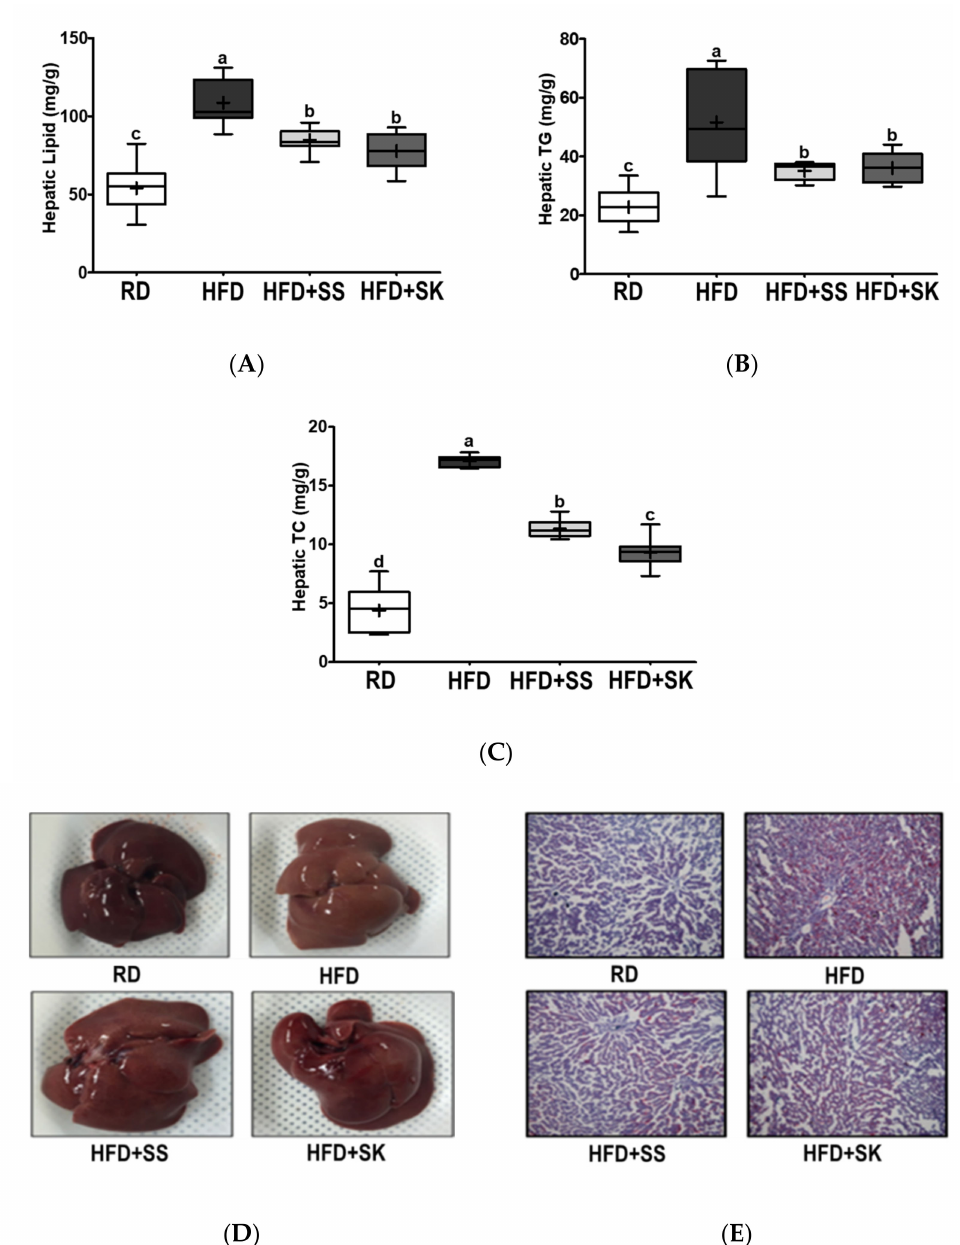
Figure 5. Effect of steamed soybean (SS) and soybean koji (SK) on fat accumulation in the liver. Experimental rats were fed a regular diet (RD) or a high-fat diet (HFD) with 3% SS (HFD+SS) or with 3% SK (HFD+SK) for 8 weeks. ( A ) Hepatic lipid, ( B ) hepatic triglyceride (TG), and ( C ) hepatic total cholesterol (TC) were measured and normalized by the measured tissue weight (g). ( D ) Harvested whole liver and ( E ) liver samples fixed and stained with Oil red O staining from each experimental group. RD, regular diet; HFD, high-fat diet; HFD+SS, high-fat diet + 3% steamed soybean; HFD+SK, high-fat diet + 3% steamed soybean. Values are displayed as a box-and-whisker plot with means (expressed as ‘+’), n = 8. Data were analyzed using one-way ANOVA followed by Tukey’s post-hoc comparison. Means labeled without a common letter differ significantly, p <